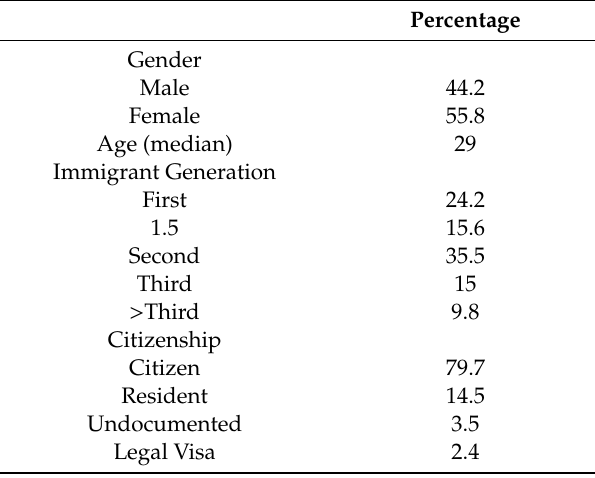
Table 1. Demographic data of